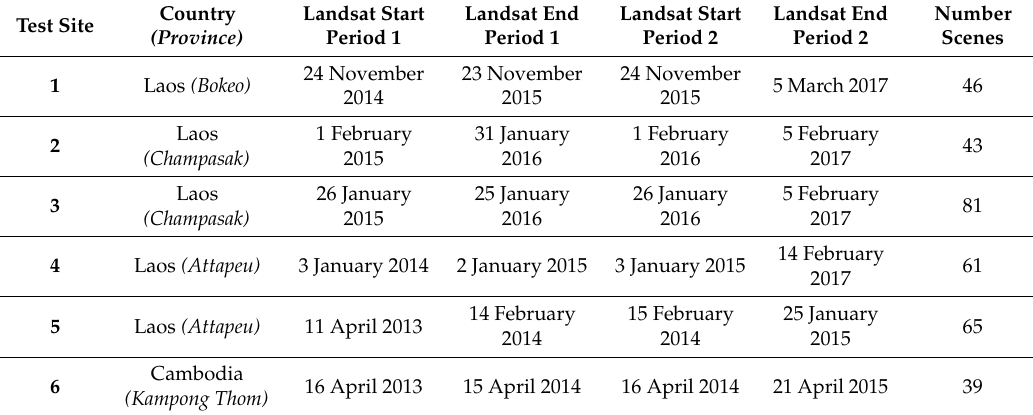
Table 2. Overview of the start and end dates of the two Landsat 8 acquisition periods for the validation exercise. The last column shows the number of Landsat 8 scenes involved to derive the ∆ rNBR per test